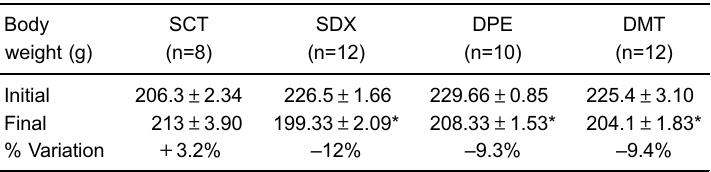
Table 1. Gain in body weight after 5 days of